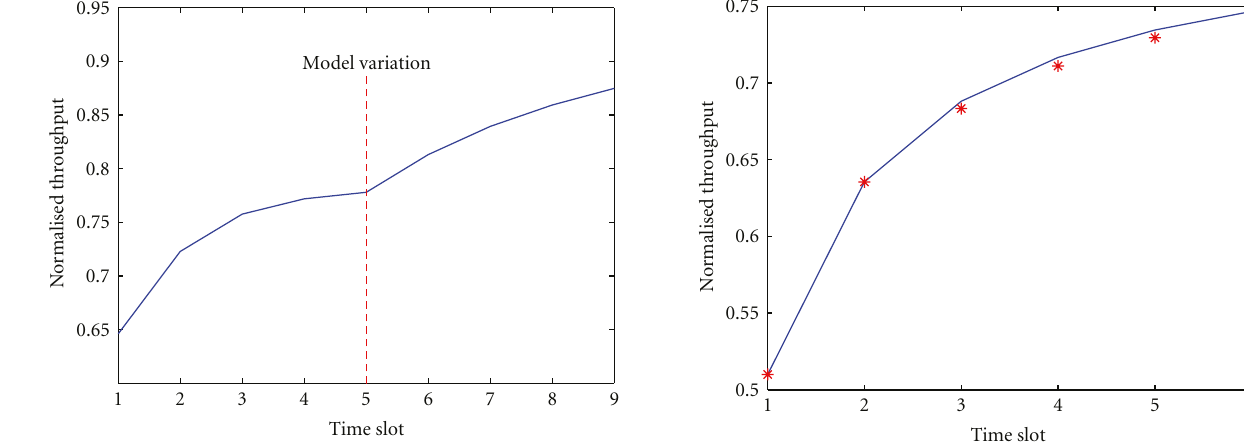
Figure 4: The robustness of the myopic policy ( N = 3, L = 2. For t ≤ 4, p (1) = 0 . 9, p (1) = 0 . 05, p (2) = 0 . 2, and p (2) = 0 . 1; for t > 4, 11 01 11 01 p (1) = 0 . 99, p (1) = 0 . 69, p (2) = 0 . 9, and p (2) = 0 . 8.). 11 01 11 01